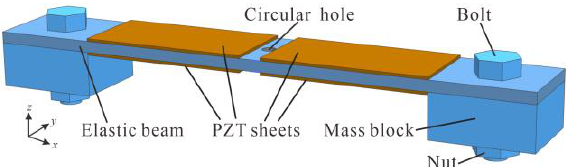
Figure 4. Piezoelectric resonator with tunable resonant frequencies.